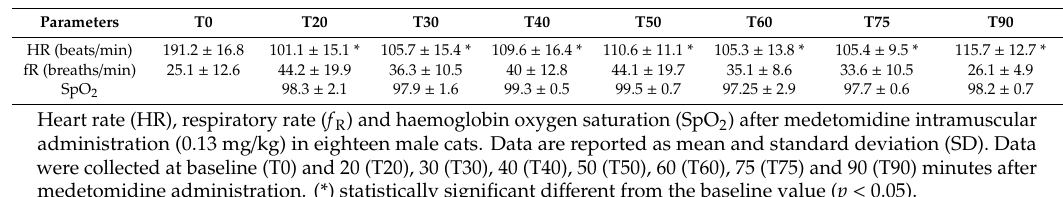
Table 1. Monitoring